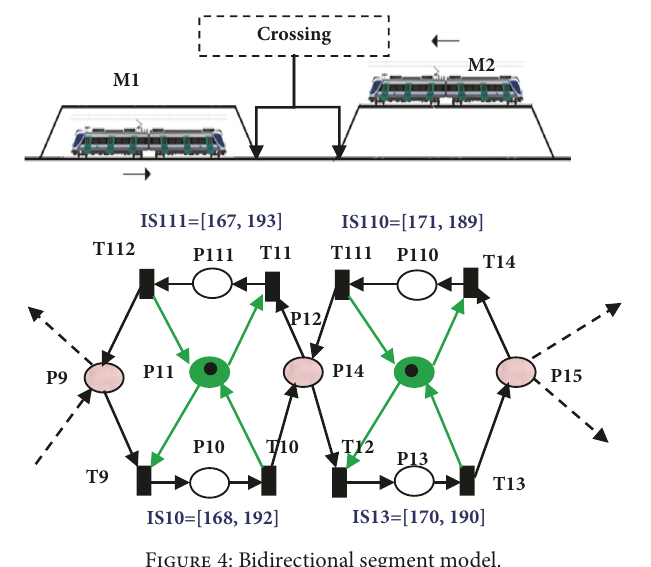
Figure 4: Bidirectional segment model.